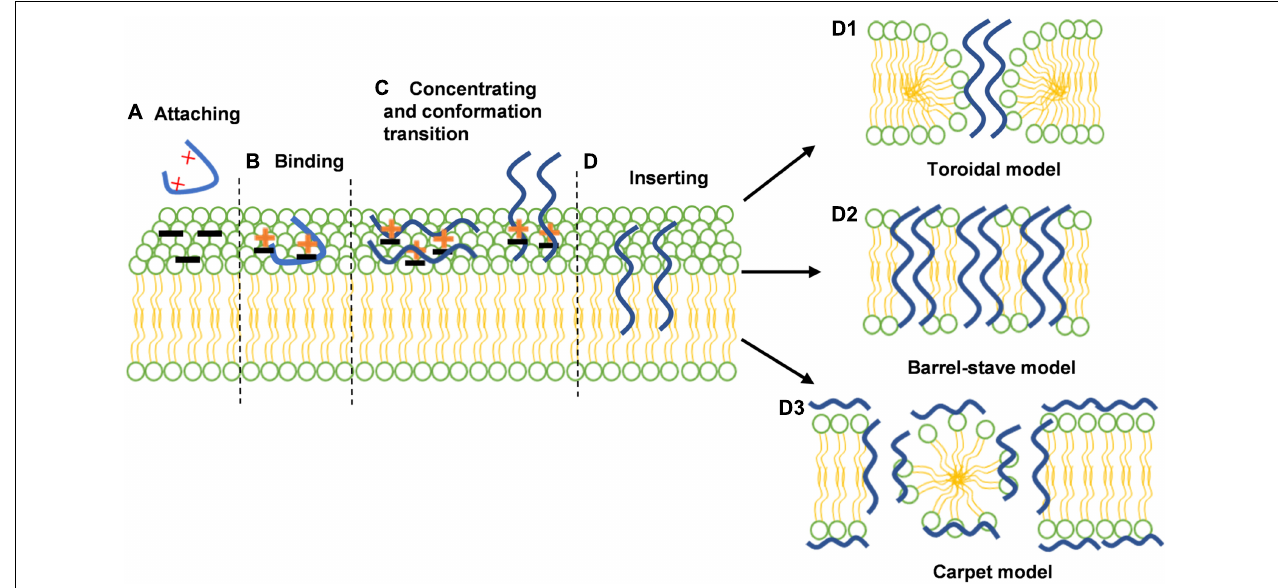
FIGURE 1 | The interactions between antimicrobial peptides (AMPs) and bacterial membranes; (A) AMPs are attracted with the negatively charged surfaces of Gram-negative (outer membrane) or Gram-positive (cell wall) bacteria by electrostatic attraction; (B) AMPs exerts a binding process with the lipopolysaccharide (LPS) of Gram-negative or lipoteichoic acid (LTA) of Gram-positive bacteria; (C) AMPs start to accumulate on the bacterial membrane surface and adopt their stable secondary structure; (D) AMPs insert into lipid bilayer and exert various membrane disruptive models of AMPs: toroidal models (D1) , barrel-stave model (D2) carpet model (D3) . the membrane is demonstrated by two colors: green represents the phospholipid head and yellow represents the tail. The AMPs are shown in the curve, highlighted in blue. Reproduced with permission (Wang et al., 2019b). Copyright 2018,